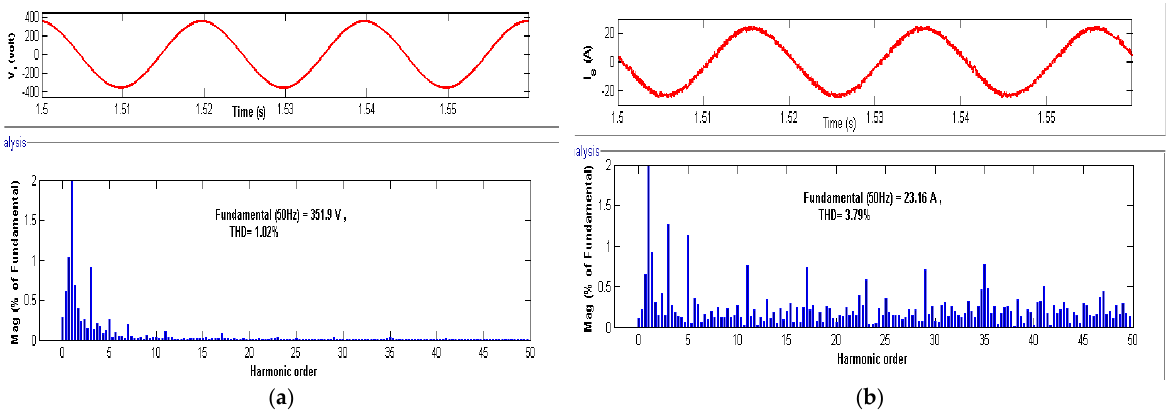
Figure 12. ( a ) Total Harmonic Distortion (THD) in source voltage ( b ) THD in source current w.r.t frequency.